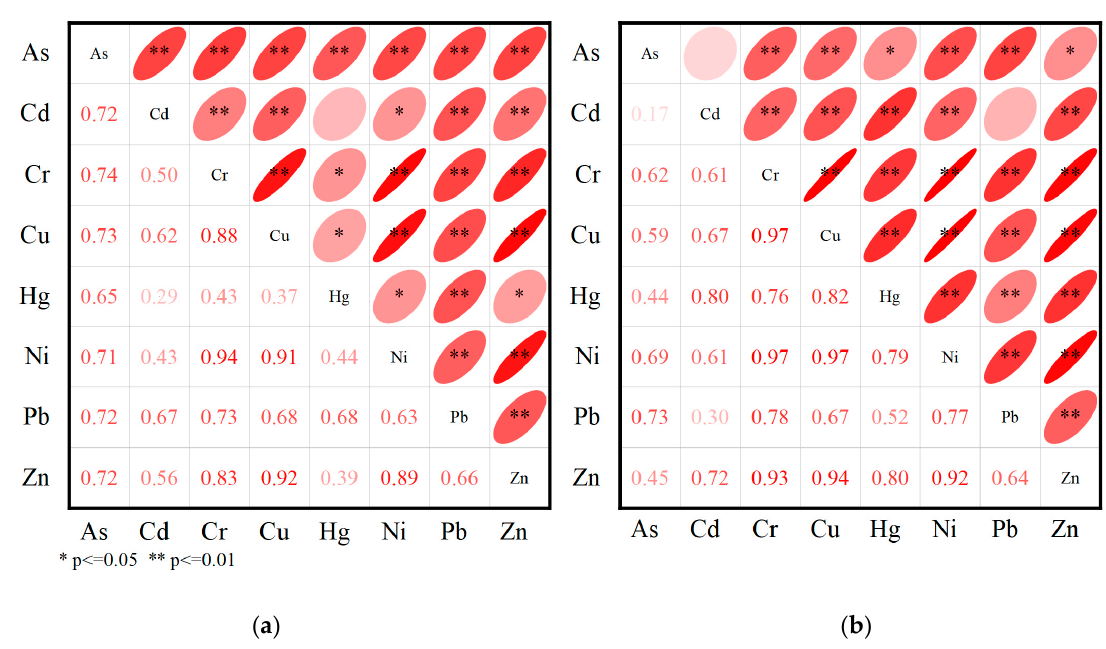
Figure 8. Plot of Pearson correlation coefficients. ( a ) Chengxi Lake; ( b ) Chengdong Lake.